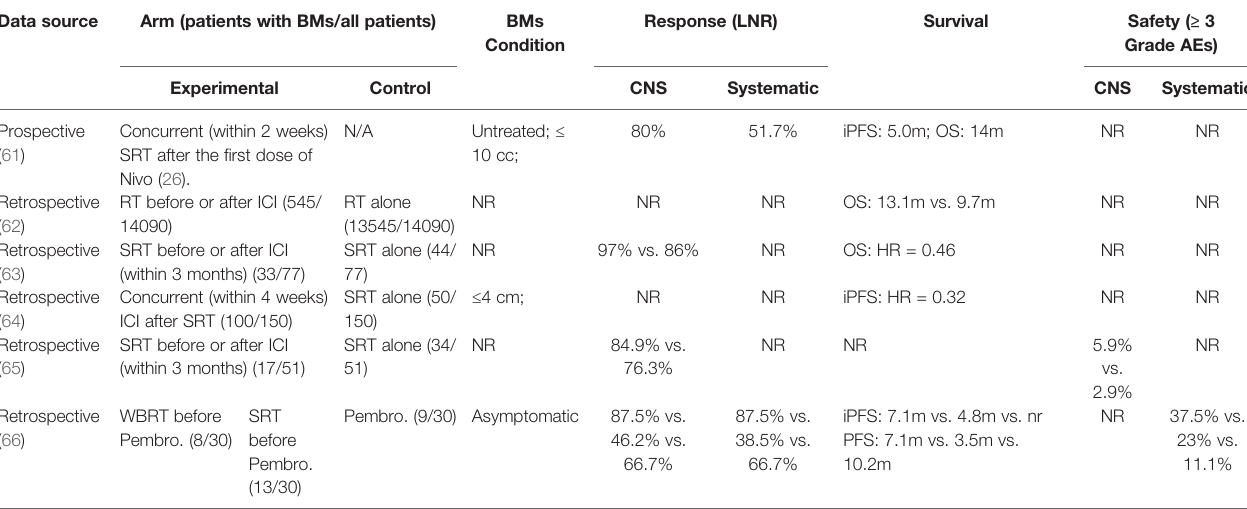
TABLE 2 | Clinical investigations of ICI and radiotherapy combination in the treatment of NSCLC patients with BMs. Data source Arm (patients with BMs/all